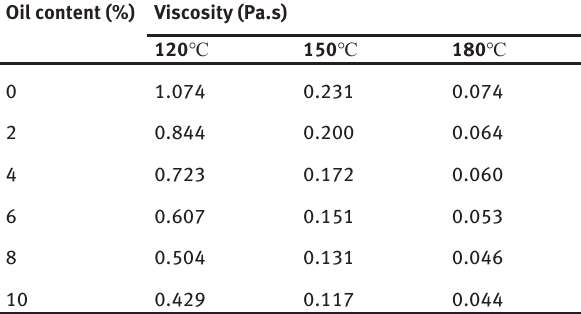
Table 1: Viscosity changes in different temperature of bitumen source [66].